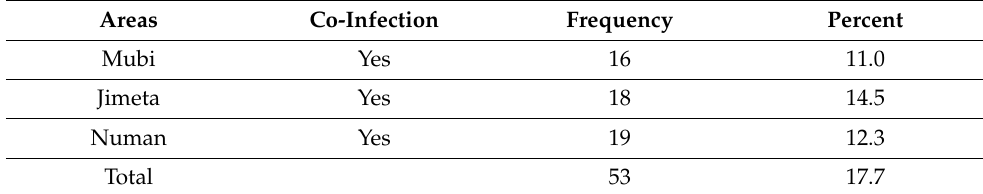
Table 6. Dengue and malaria co-infection.